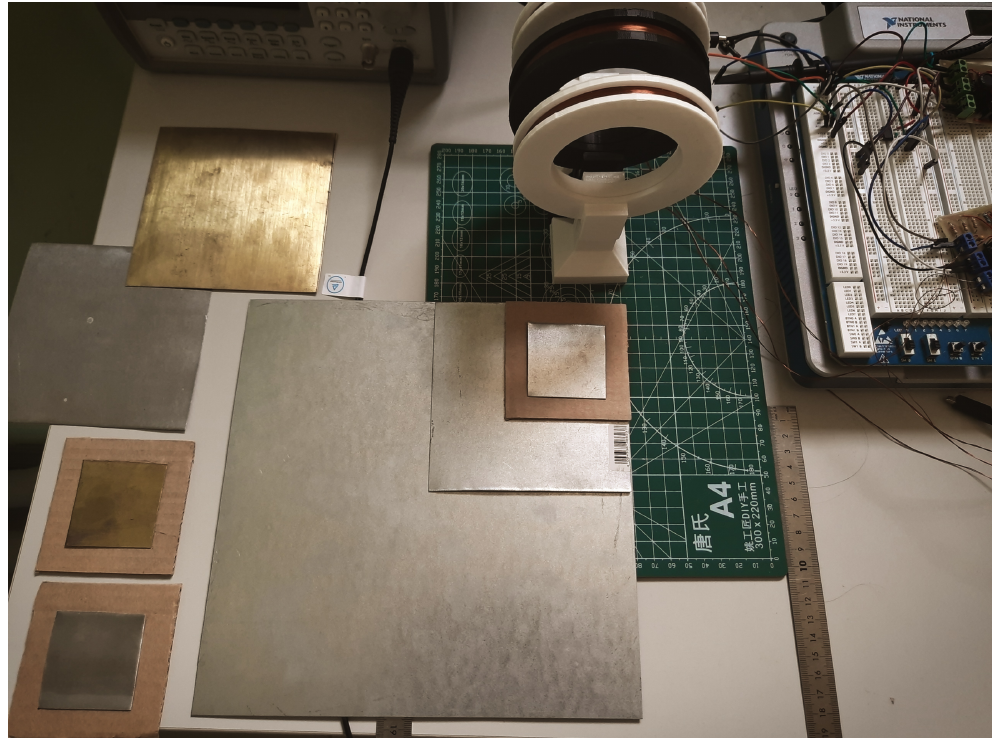
Figure 18. Targets: square metal plates of steel, aluminium and brass of sizes 25 × 25 cm, 12 × 12 cm and 5 × 5